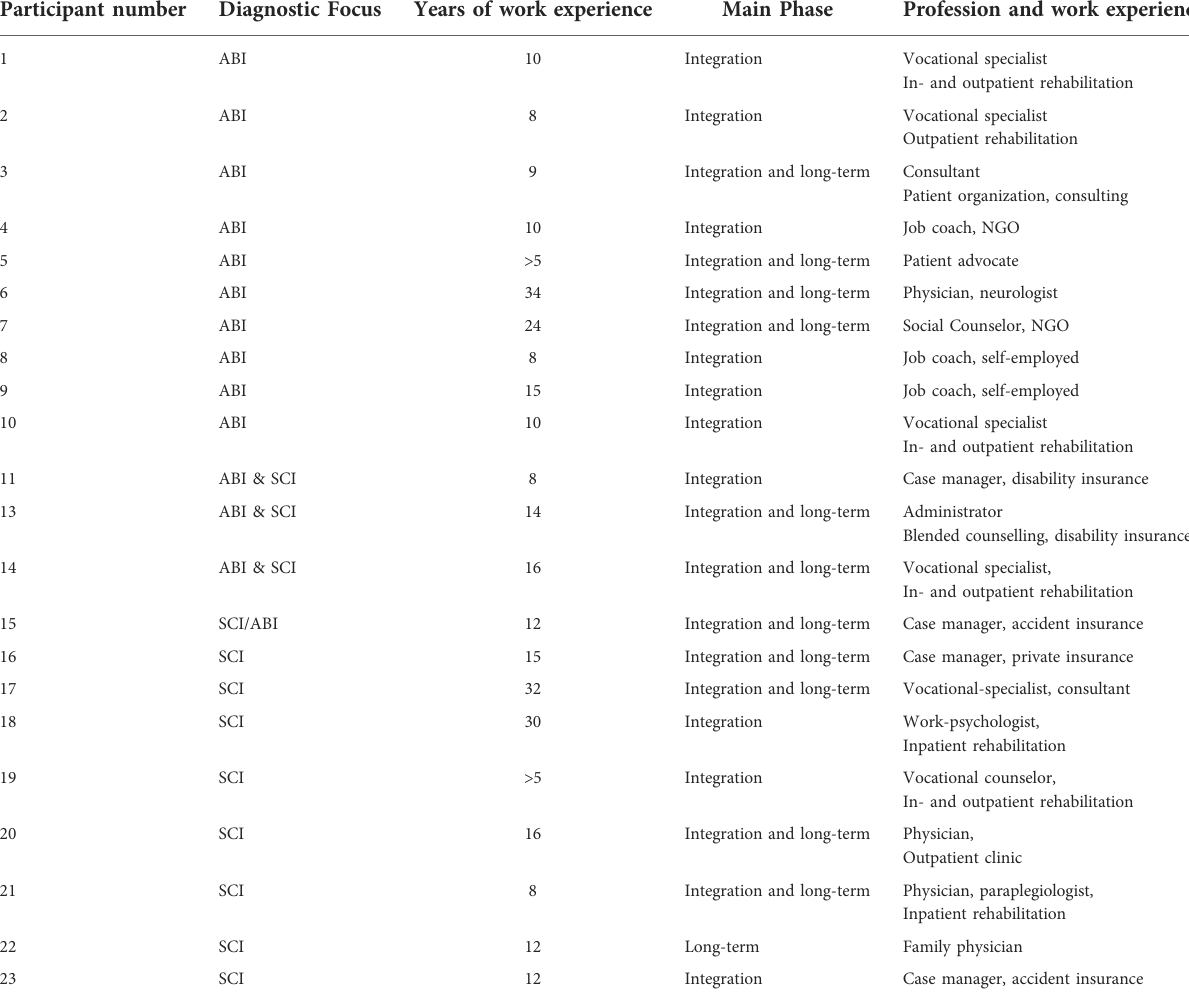
TABLE 1 Participants